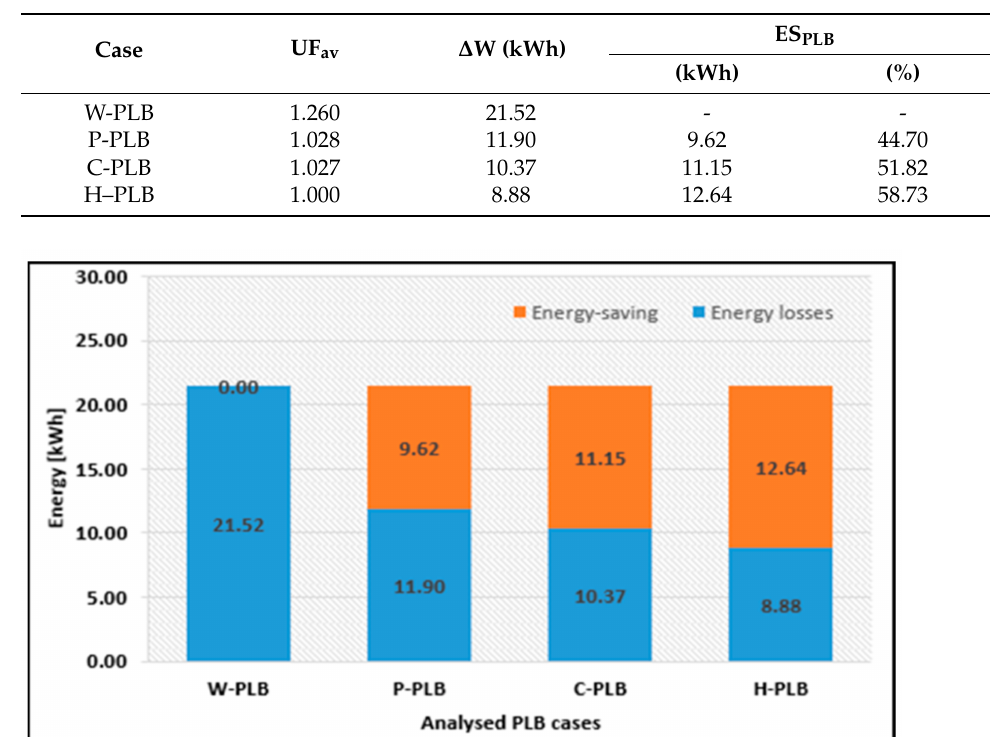
Table 8. Comparison between the technical indicators of the AEDN in the analysed cases.